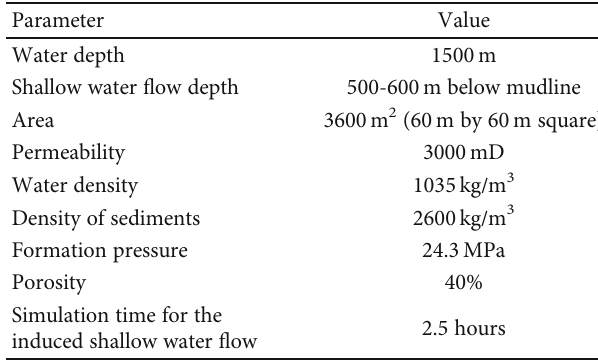
Figure 2: Veri fi cation for water production against published production data. Table 2: Parameters for the water production veri fi cation